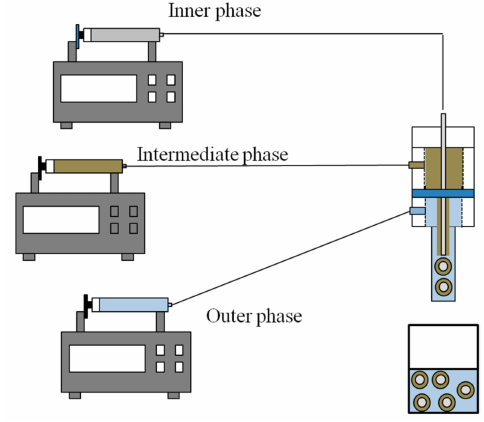
Figure 1. Schematic diagram of the preparation system.